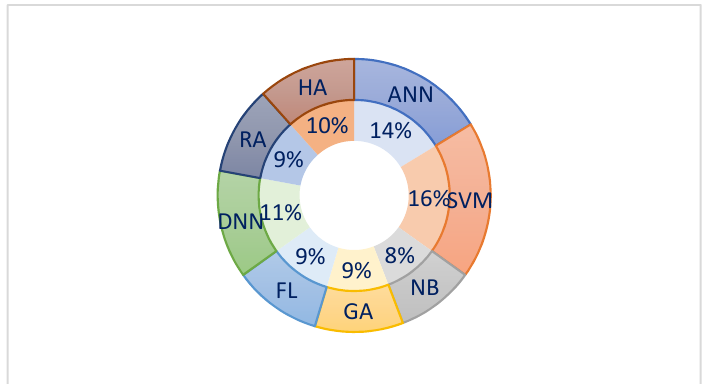
Figure 6. Distribution of the SMP techniques.